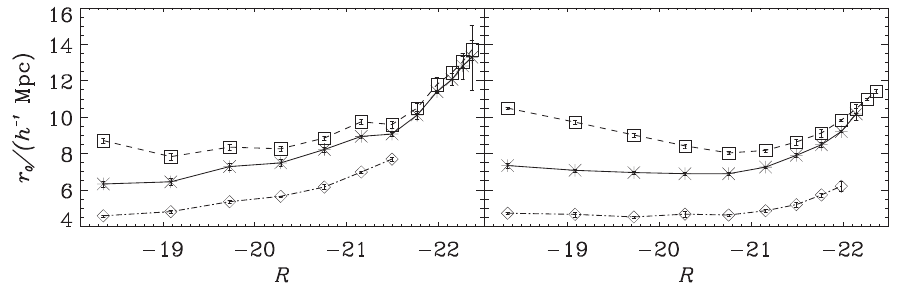
Fig. 3. Correlation length as a function of mean R -magnitude. Left panel: SDSS samples from m1 to m12 for all galaxies (stars and solid line), red galaxies (open squares and dashed lines), and blue galaxies (open diamonds and dash-dotted line). Right panel: idem as left panel but for mock samples in the G11 model. Error bars represent 2 standard deviations, they are smaller than the symbols.